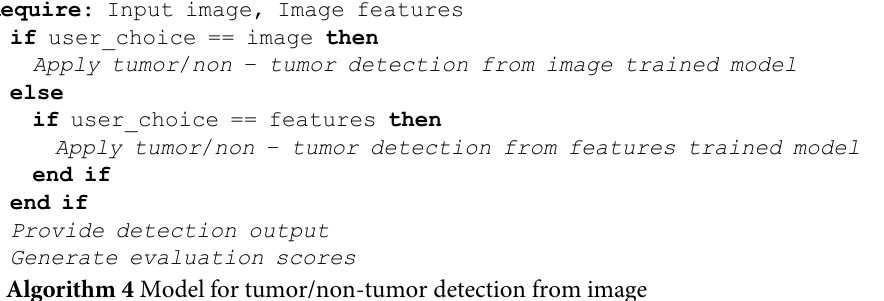
Algorithm 4 Model for tumor/non-tumor detection from image